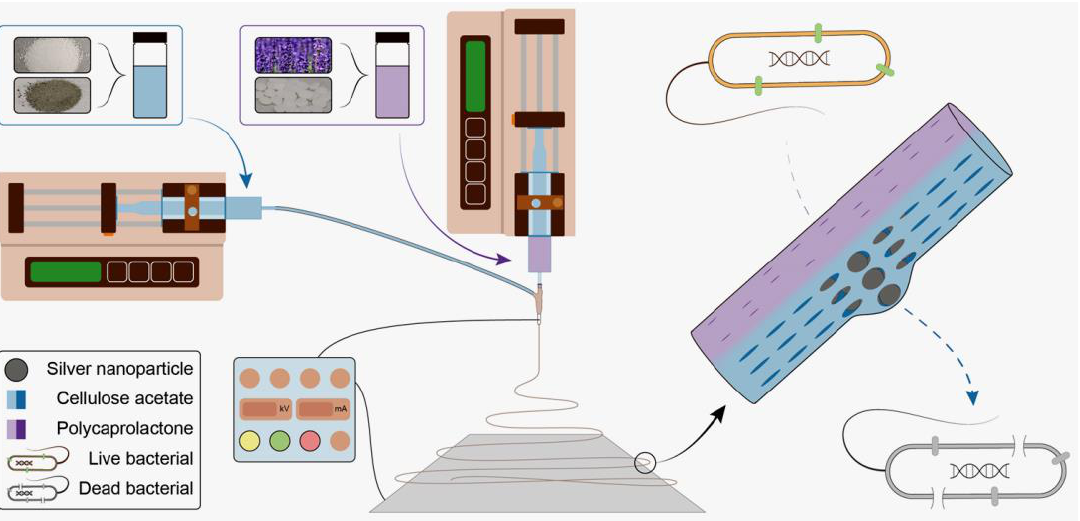
Figure 1. Schematic diagram of preparing solutions, side-by-side electrospinning process and Janus